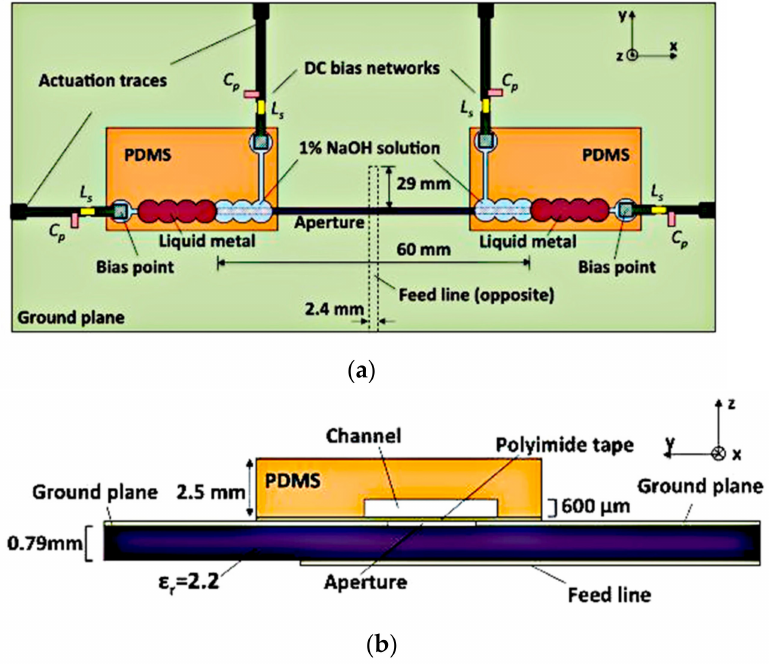
Figure 5. Frequency reconfigurable antenna. ( a ) Top view. ( b ) Side view [42]. Meanwhile, the upper arm of a planar inverted-F antenna (PIFA) with Galinstan liquid metal was presented in [22]. The Galinstan liquid is filled in a Teflon tube, as shown in Figure 6. To prevent the fluidic channel from being folded, each corner of the Teflon tube are rounded at a certain